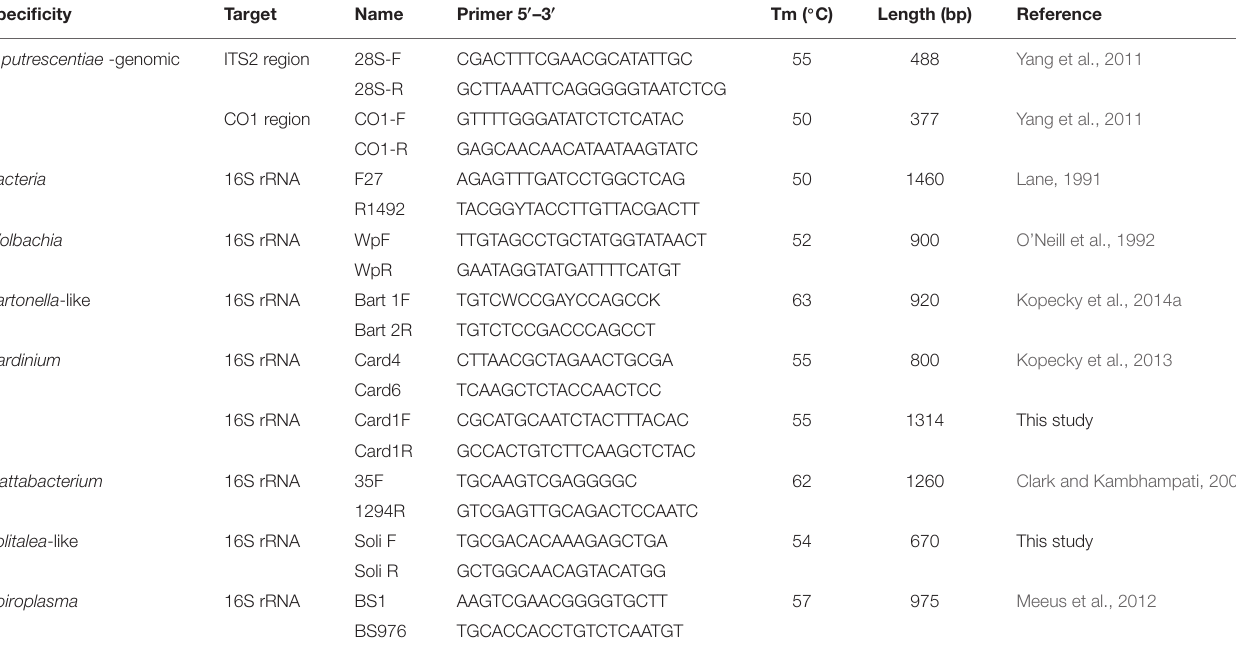
TABLE 2 | Primers used for characterization of Tyrophagus putrescentiae populations and detection of bacterial community.